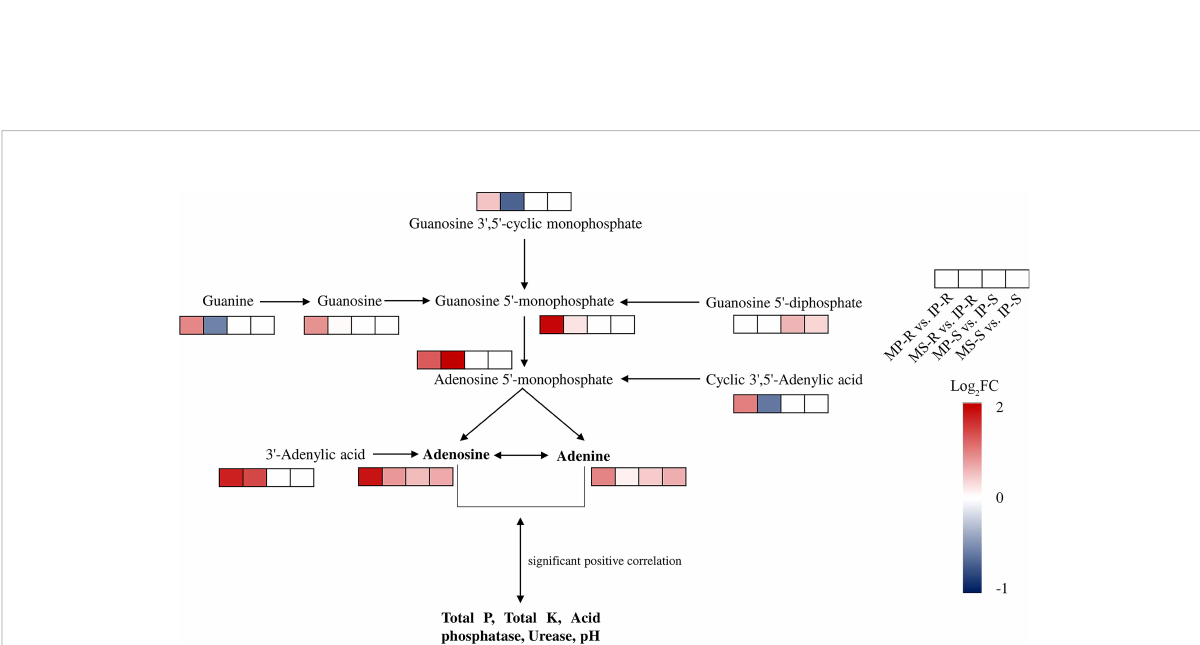
FIGURE 6 Abundance of the metabolites enriched in purine metabolism compared intercropping treatment with monoculture treatment. The screening of the metabolites was based primarily on one of the comparison groups or multiple comparison groups with a fold change (FC) greater than or less than 1.5, and Log 2 FC processing was performed to draw heatmaps. The FC of MP-R vs. IP-R and MS-R vs. IS-R were mean of three replicates, and the FC of MP-S vs. IP-S and MS-S vs. IS-S were mean of six replicates. The red and blue of small rectangle indicated that up- regulated and down-regulated of metabolite content, respectively; the transparent colorless small rectangle indicated that the metabolite was not